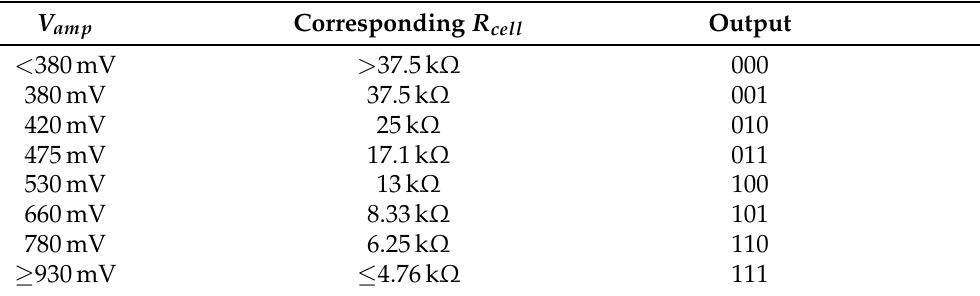
Table 3. Read circuit measurement